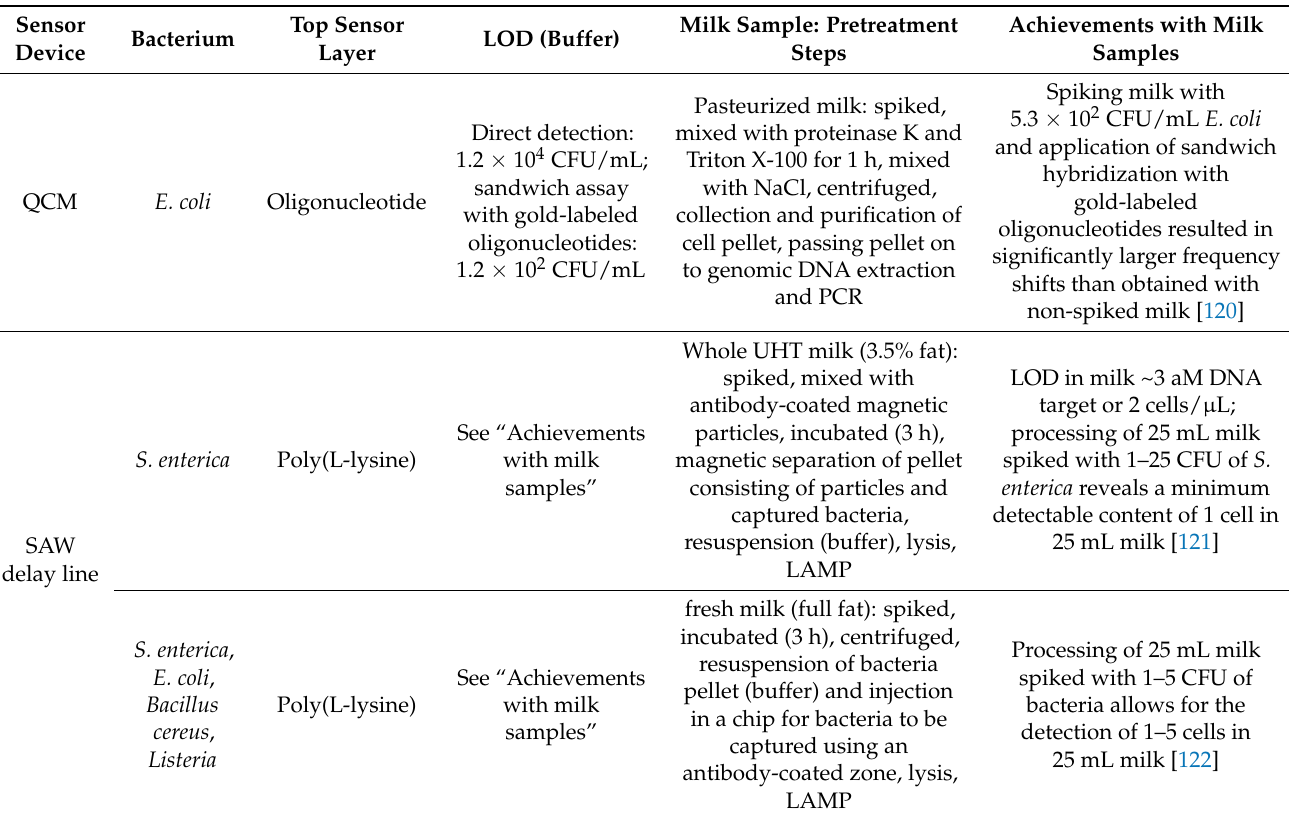
Table 6. Detection of probiotic and pathogenic bacteria in cow’s milk using cell lysis and DNA- amplification